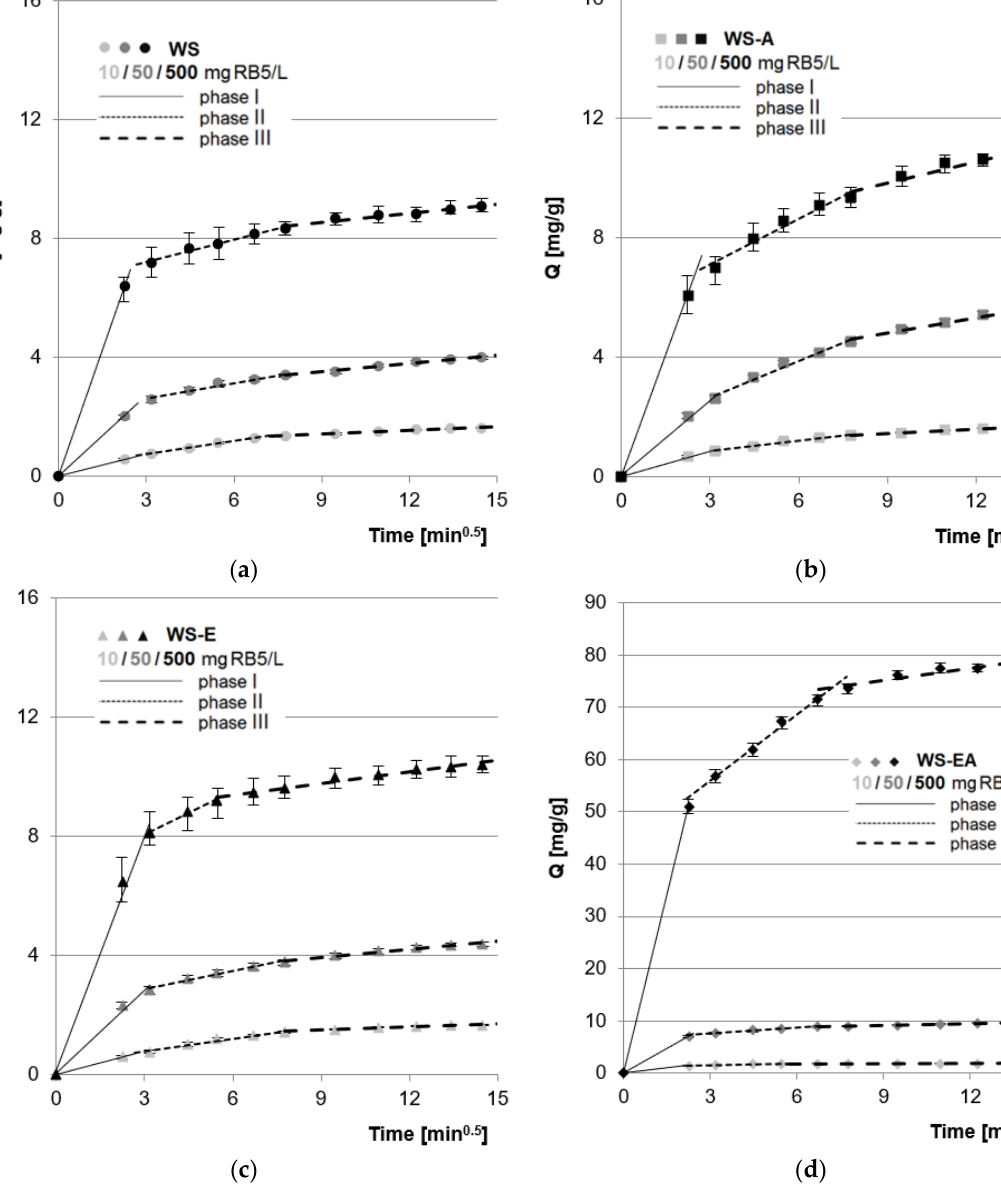
Figure 5. Intramolecular diffusion model of RB5 sorption onto: ( a ) WS; ( b ) WS-A; ( c ) WS-E; and ( d ) WS-EA, (average + range). Conc. of the solution: 10–500 mg RB5/L, dose of the sorbent: 5 g/L, mixing speed: 150 r.p.m., sorption time: 0–240 min, temp. 22 °C.